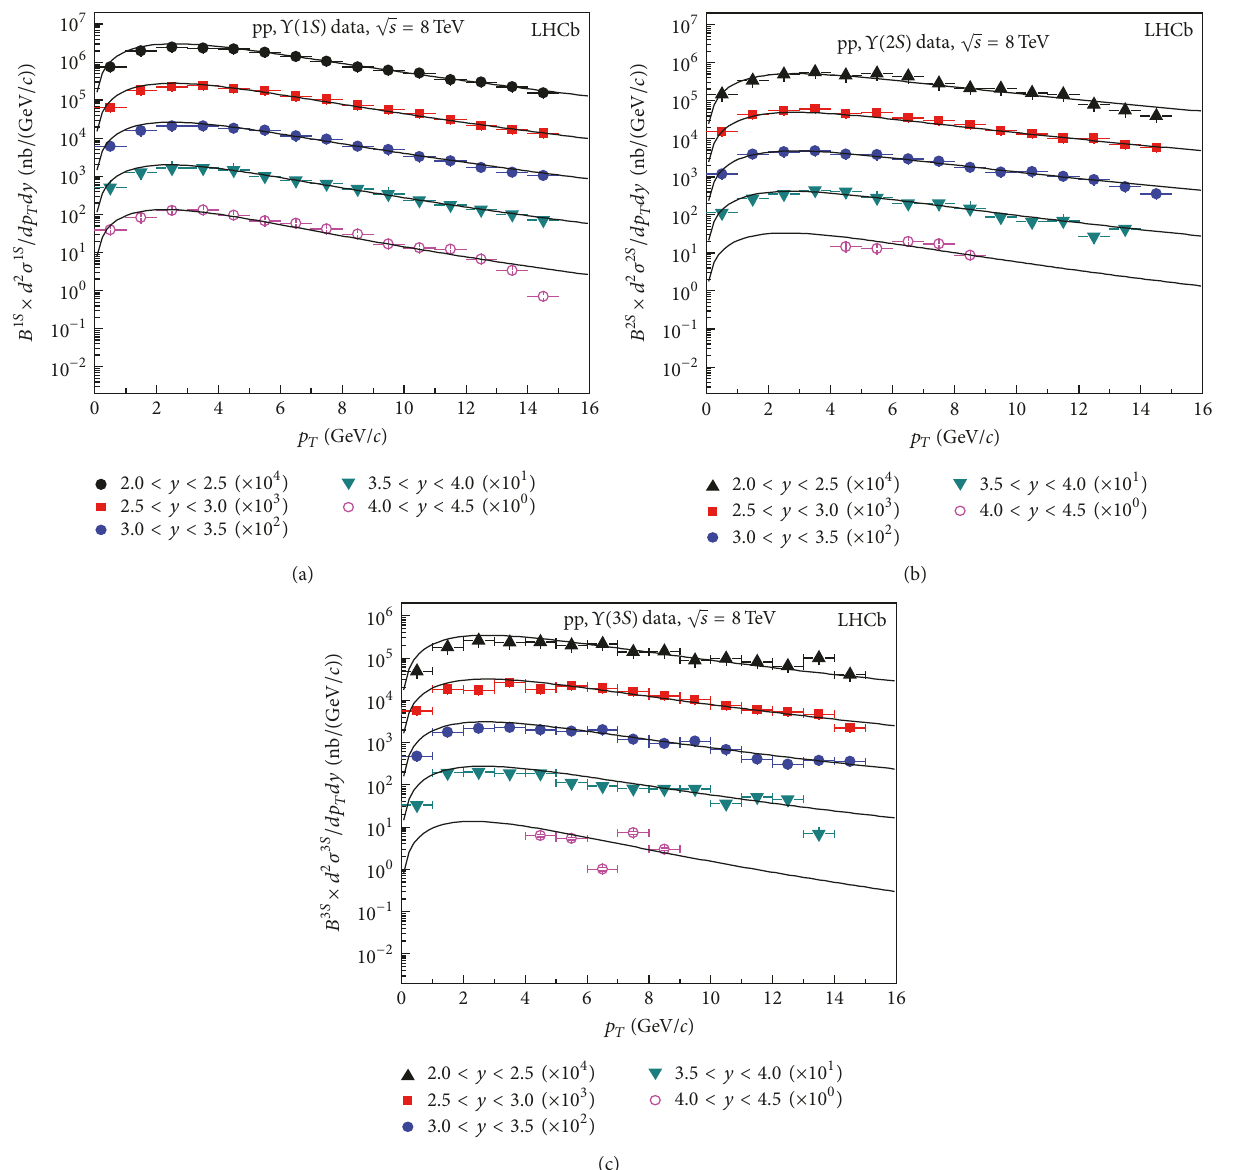
Figure 3: Double-differential cross section 𝑑 2 𝜎/𝑑𝑝 𝑇 𝑑𝑦 as a function of 𝑝 𝑇 in bins of 𝑦 for (a) Υ(1𝑆) , (b) Υ(2𝑆) , and (c) Υ(3𝑆) mesons in p-p collision at √𝑠 NN = 8 TeV. The symbols indicate the experimental data of the LHCb Collaboration [25]. The solid lines indicate our theoretical